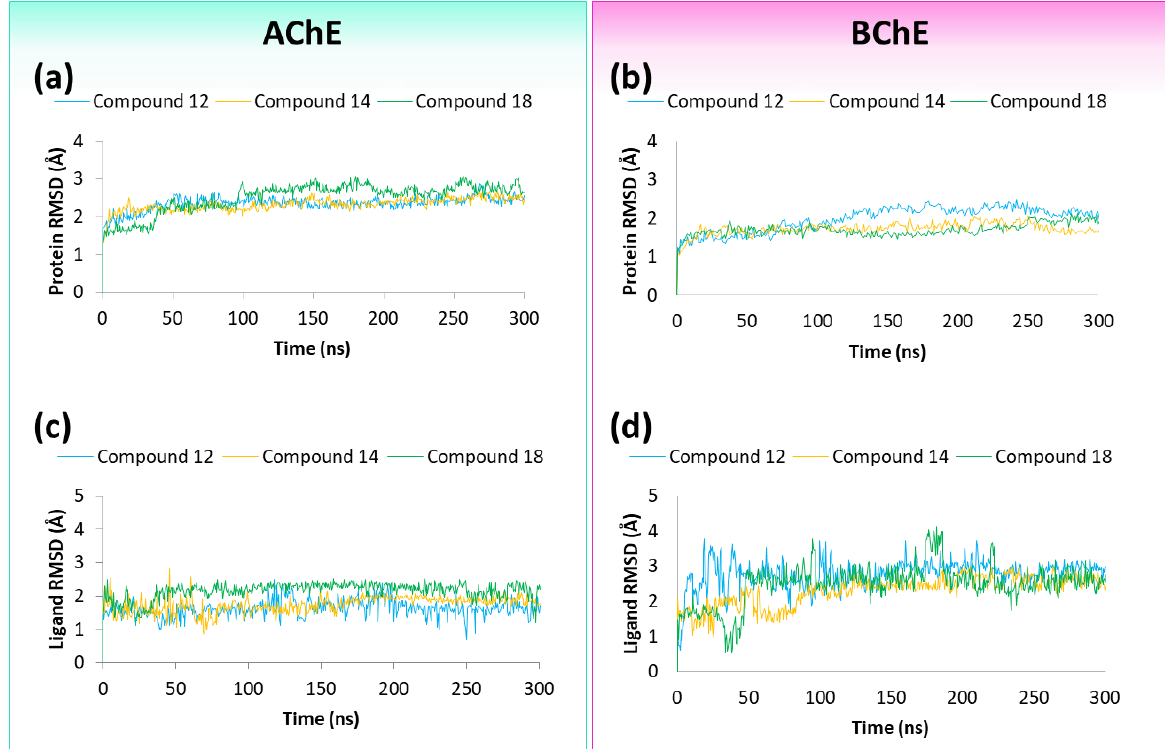
Figure 6. Protein RMSD and Ligand RMSD plots of compounds 12 , 14 and 18 to ( a , c ) h AChE and ( b , d ) h BChE, respectively.